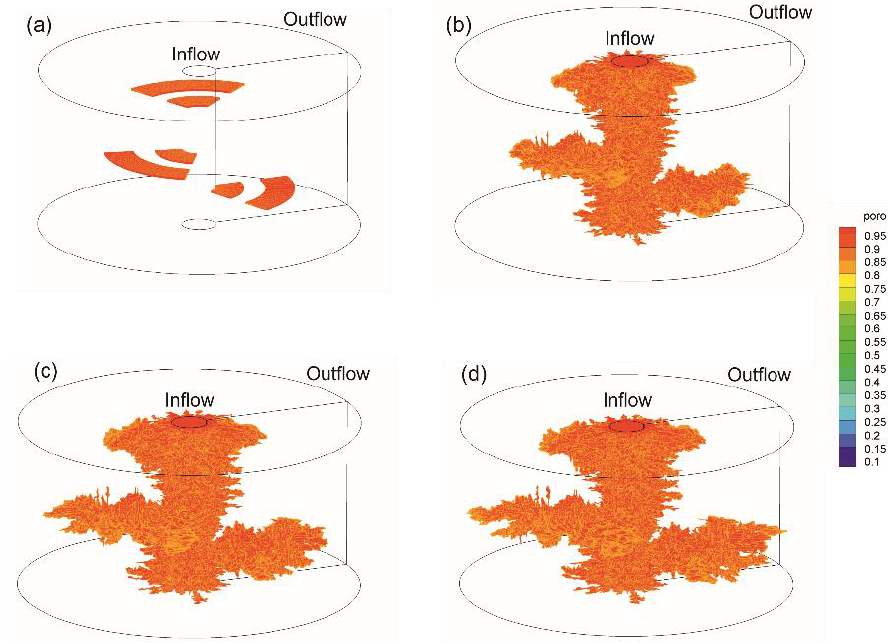
Figure 11. Temporal and spatial evolution of porosity. ( a ) initial condition; ( b ) 14.4 min; ( c ) 28.8 min; ( d ) 47.4 min (breakthrough).